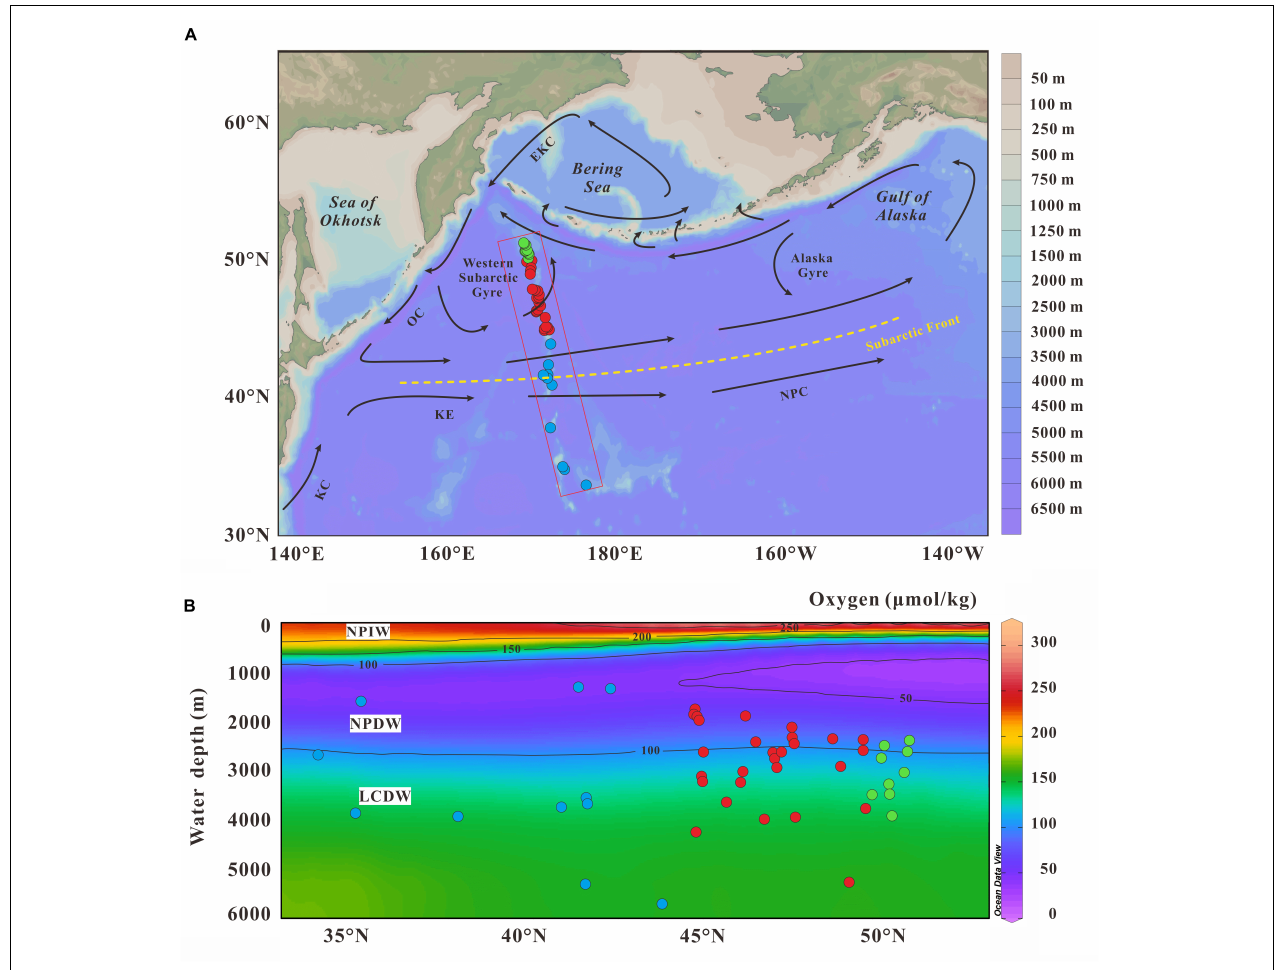
FIGURE 1 | The map of sites locations, schematic of ocean circulation (A) (Wang et al., 2016) and the sectional view of dissolved oxygen concentration (B) of SO264 surface sediments from the Emperor Seamount Chain in North Pacific Ocean. The study sites are marked with red, blue, and green dots in panels (A,B) . Blue dots, red dots and green dots represent samples in zone I, II, and III, respectively. Black arrows and yellow dashed lines denote surface ocean circulation and Subarctic Front (Aydin et al., 2004), respectively. EKC = East Kamchatka Current, KC = Kuroshio Current, KE = Kuroshio Extension, NPC = North Pacific Current, OC = Oyashio Current. Map drawn with Ocean Data View (Schlitzer, 2002). NPIW = North Pacific Intermediate Water, NPDW = North Pacific Deep Water, LCDW = Lower Circumpolar Deep Water.